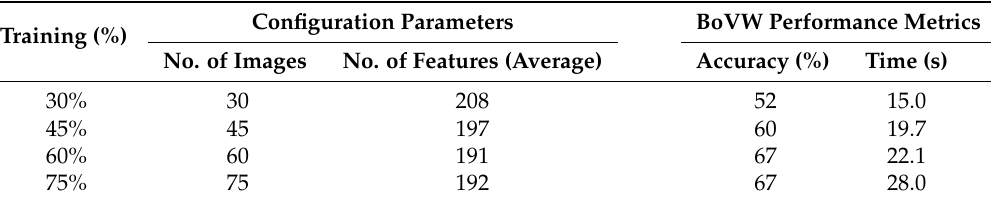
Table 2. Performance of the BoVW using maximally stable extremal regions (MSER) for points-of-interest detection and the SURF detector for feature description at every detected point. The table represents the number of images used in the training process, while the rest of the database is used for evaluation. The processing time is measured in seconds.